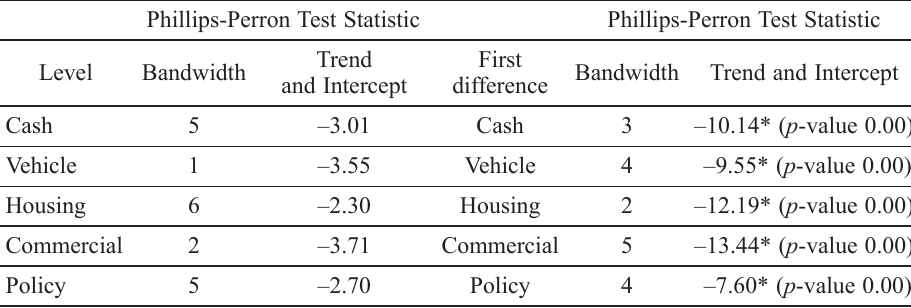
Table 2. Phillips-Perron unit root test results for all